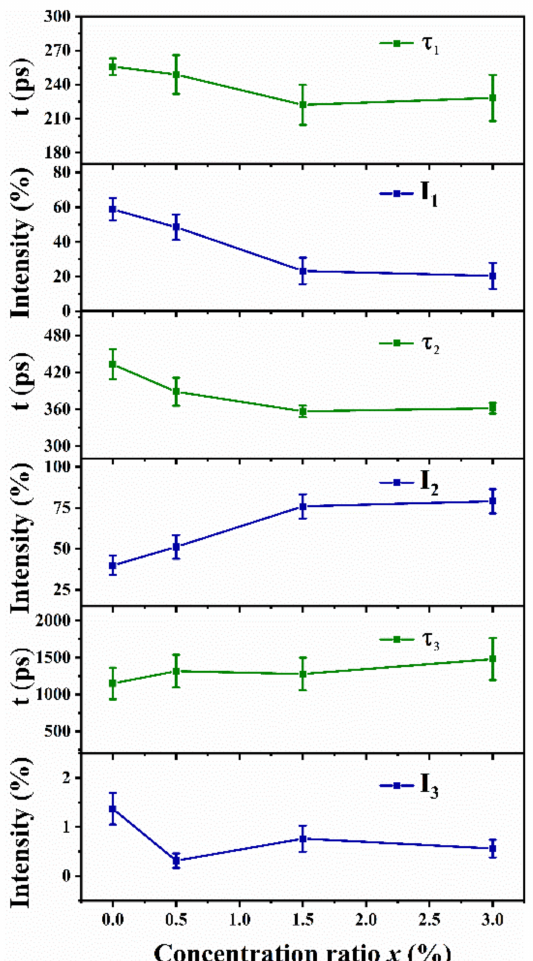
Figure 5. The positron lifetime spectra τ 1 , τ 2 , τ 3 and I 1 , I 2 , I 3 of Zn-VO 2 (B) with different x